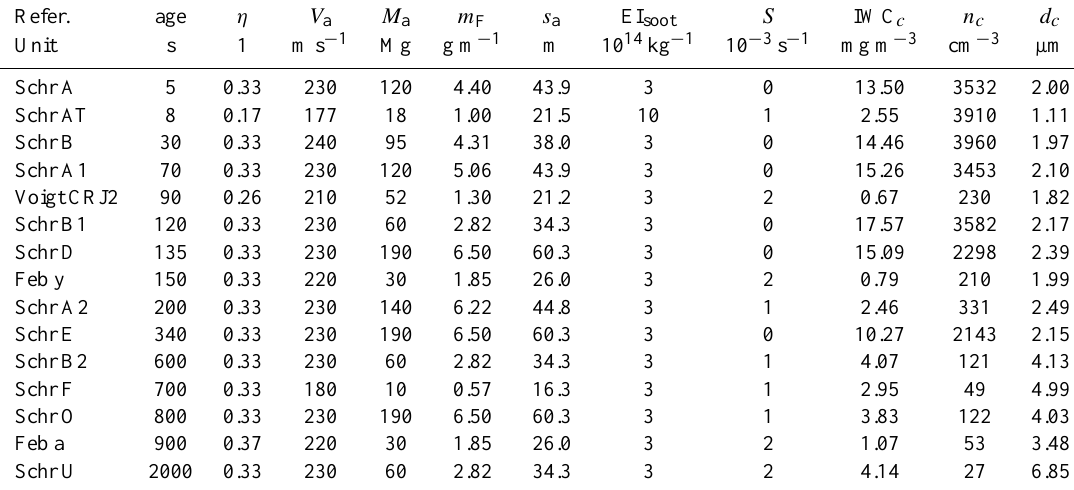
Table 5. Input and results of contrail simulation. The last three columns list the CoCiP output. References as in Table 4.